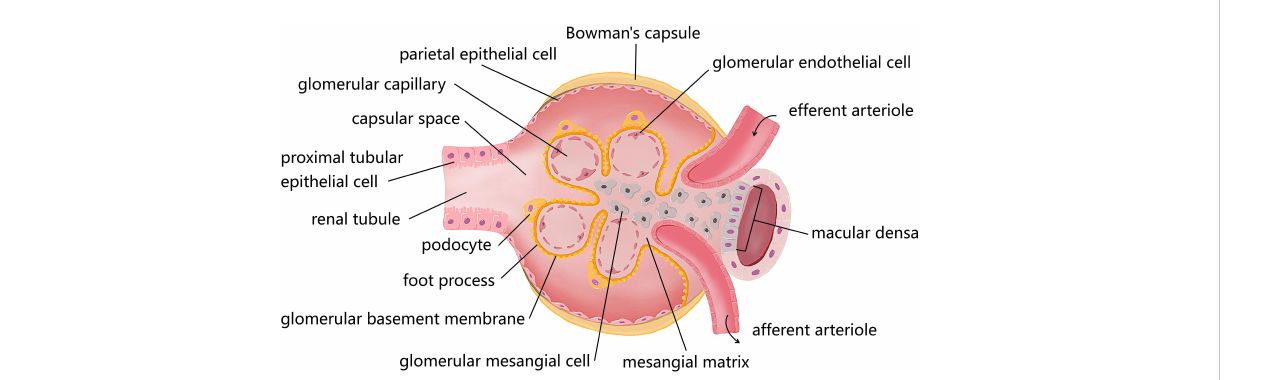
FIGURE 1 The diagram of resident cells in the glomerulus and proximal tubule. There are four kinds of major resident cells in the glomerulus, glomerular endothelial cells (GEnCs), podocytes, glomerular mesangial cells (GMCs), and parietal epithelial cells. Tubular epithelial cells form the extension of Bowman ’ s capsule, that is, the renal tubule. Podocytes with their interdigitating foot processes are arranged on the lateral side of the glomerular basement membrane (GBM). GMCs located between glomerular capillary loops, adjacent to endothelial cells or basement membranes are irregularly shaped. GEnCs are fl at cells attached to the GBM. GEnCs and podocytes form the glomerular fi ltration barrier.